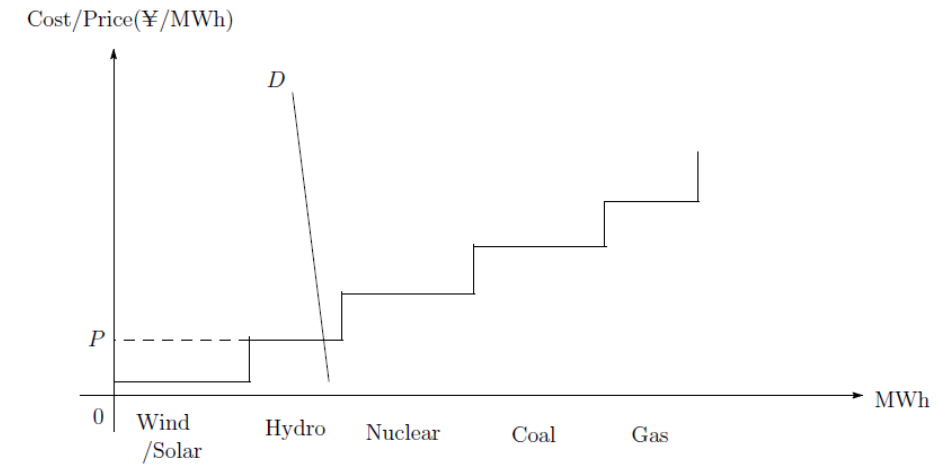
Figure 2. Electricity Market